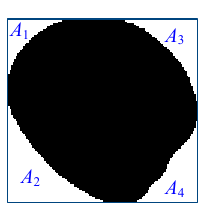
Figure 7. Symmetrical area ratio.